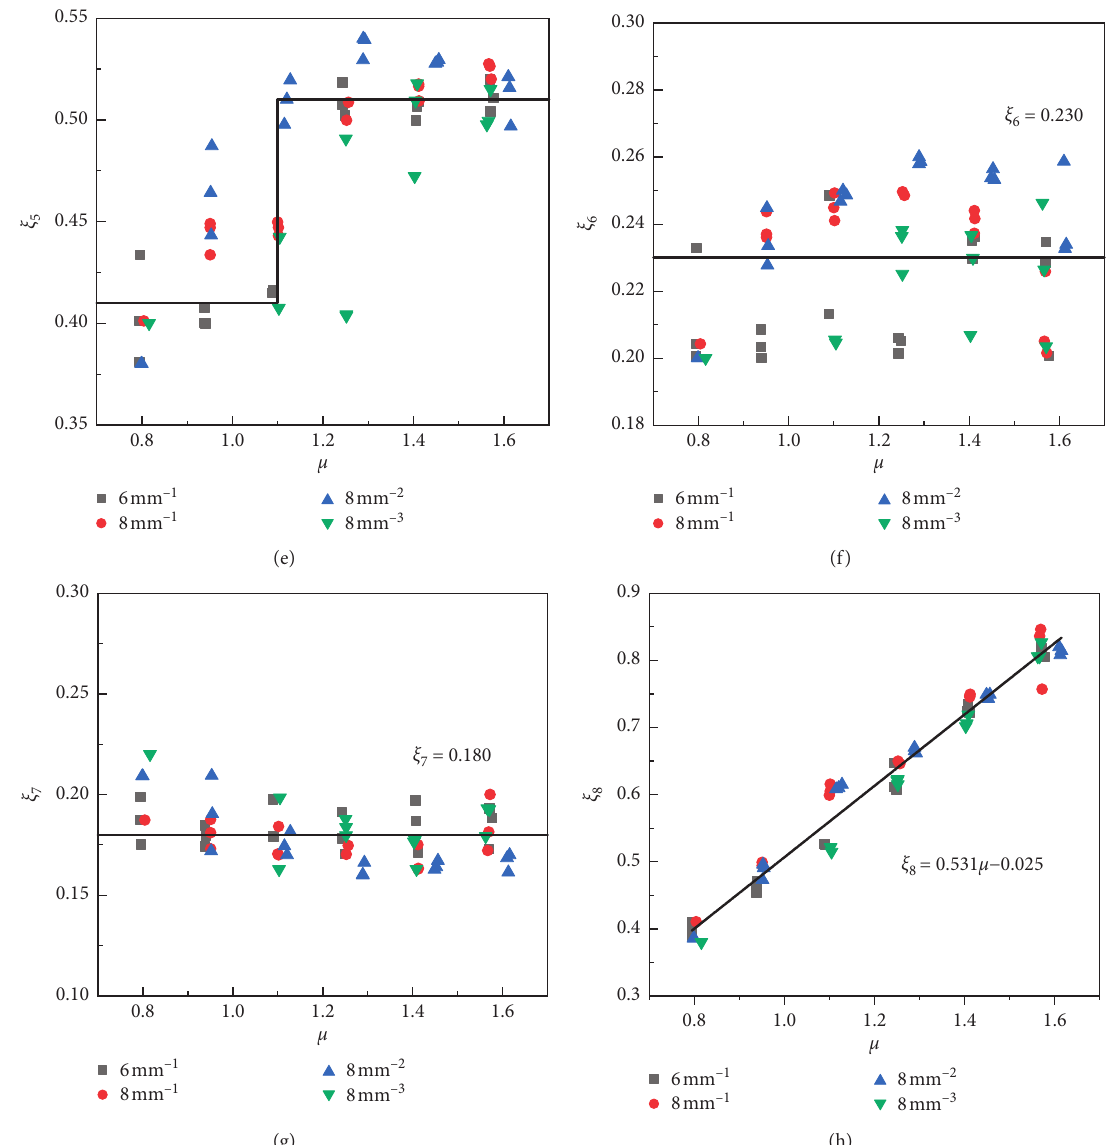
Figure 17: Parameters optimized by the GA: (a) ξ